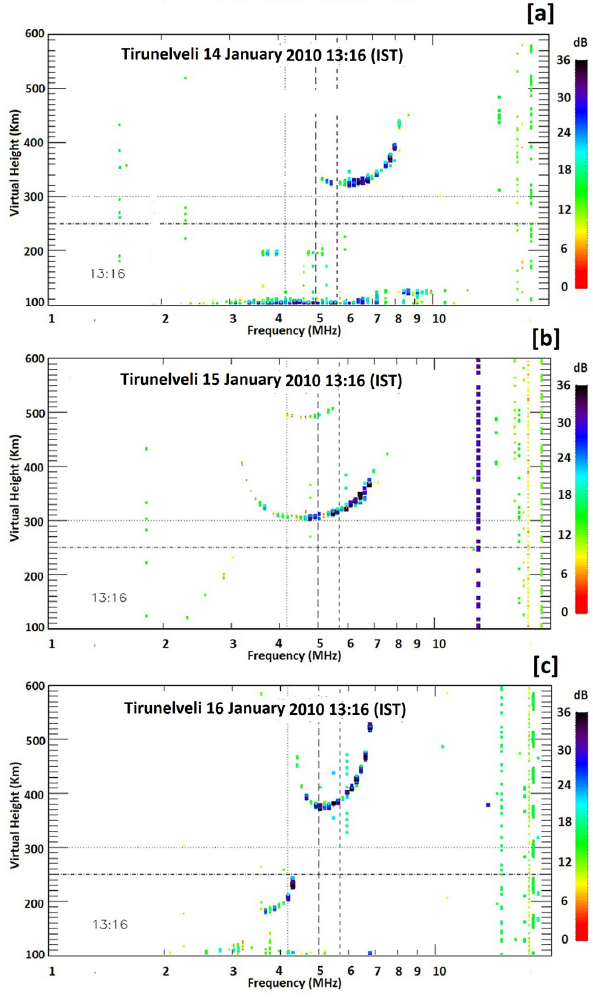
Fig. 2. Ionograms recorded at 13:16IST (when the eclipse mag- nitude was maximum) on (a) 14 January, (b) 15 January and (c) 16 January 2010.